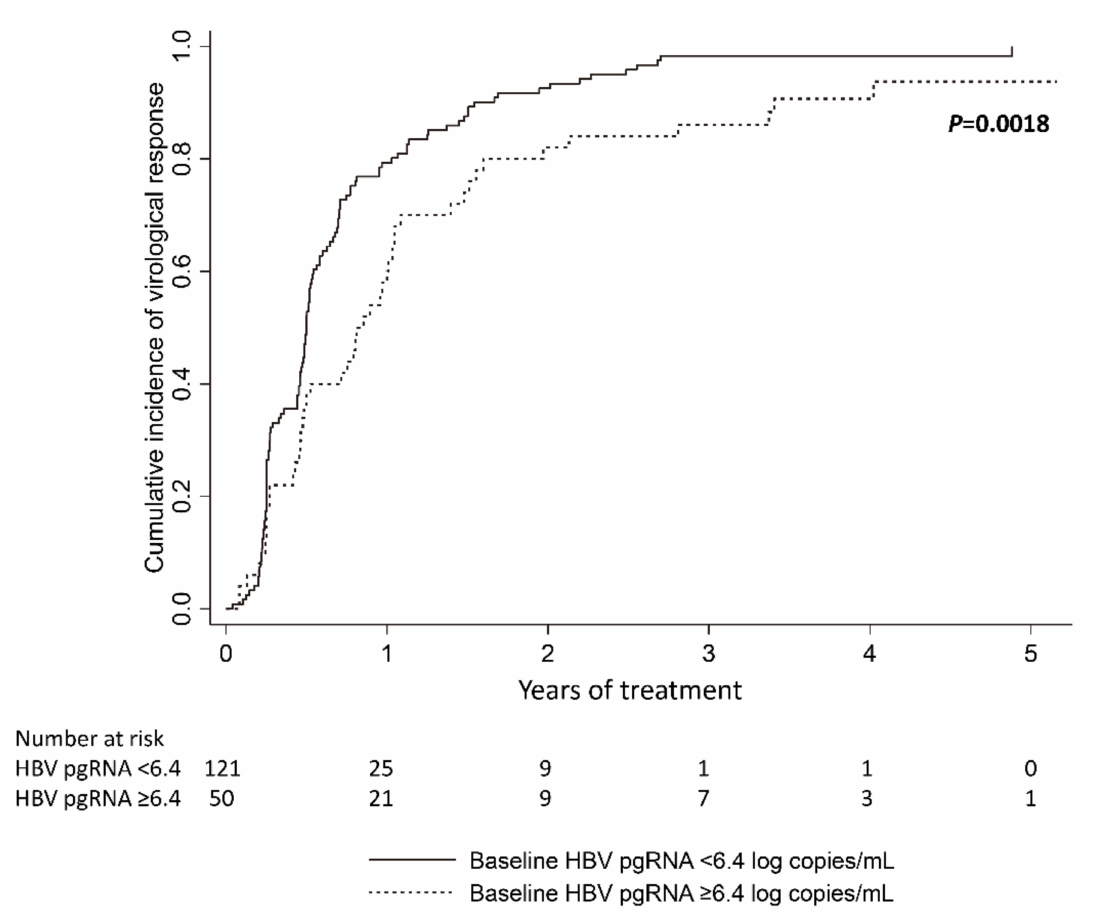
Figure 5. Cumulative incidence of virological response during entecavir treatment. Table 2. Univariate and multivariate analyses of factors associated with virological response during entecavir therapy.